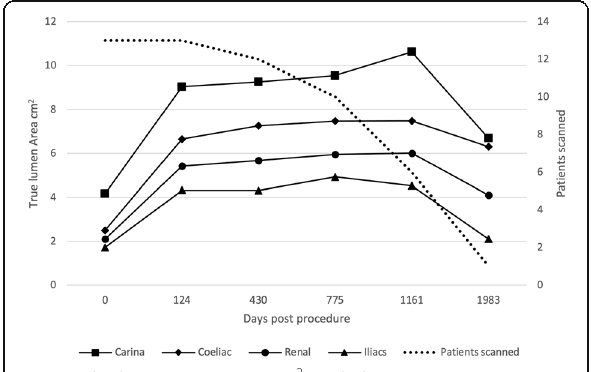
Fig. 6 False lumen aortic area (cm 2 ) excluding cases requiring